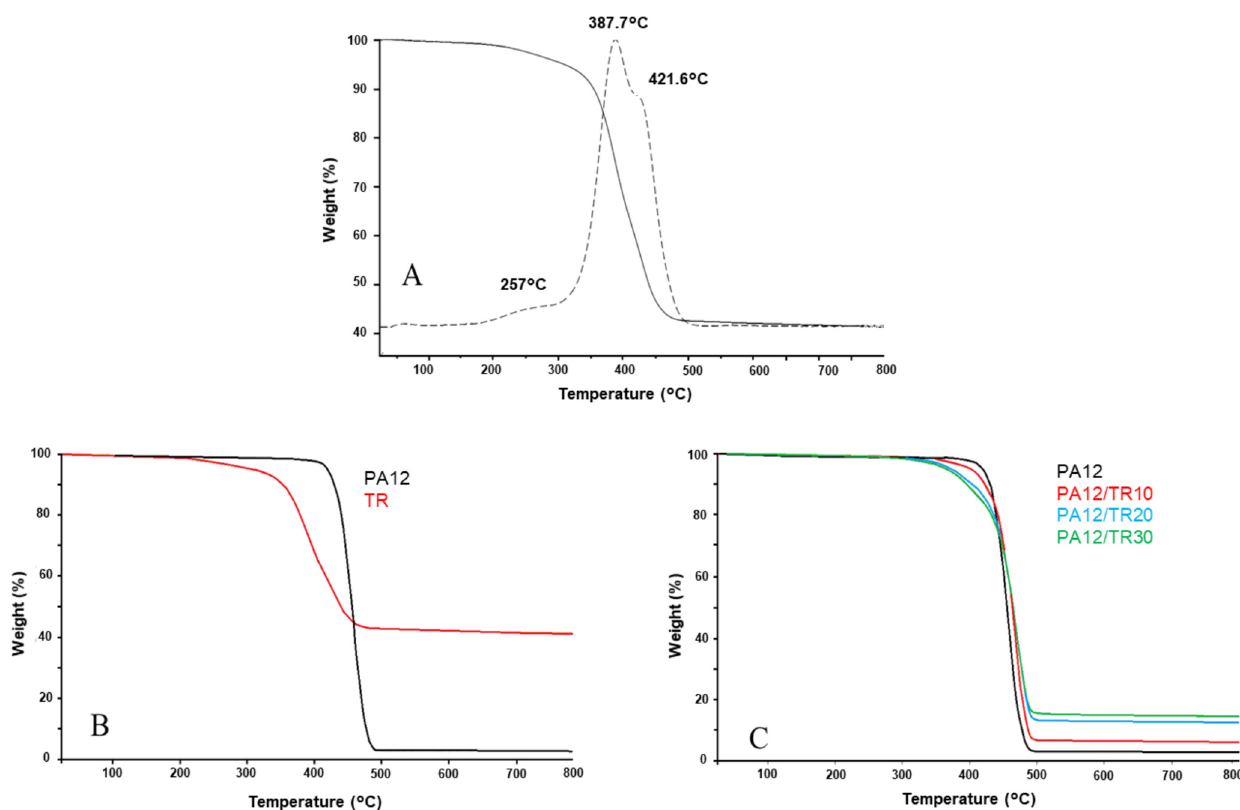
Figure 4. TGA thermograms of TR powder ( A ), PA12 printed sample and TR powder ( B ), and PA12(/TR) printed samples ( C ). Table 1. TGA analysis of TR, PA12/TR-based materials, and TR content in the printed materials.